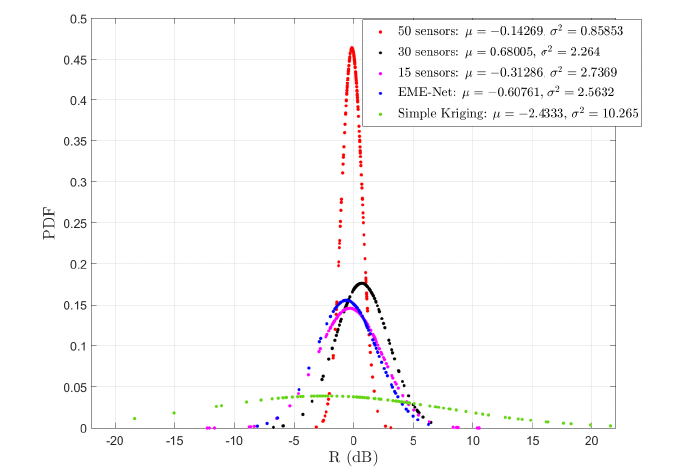
Figure 11. The probability density of the ratio R between the reconstructed map and real map when different numbers of sensors are